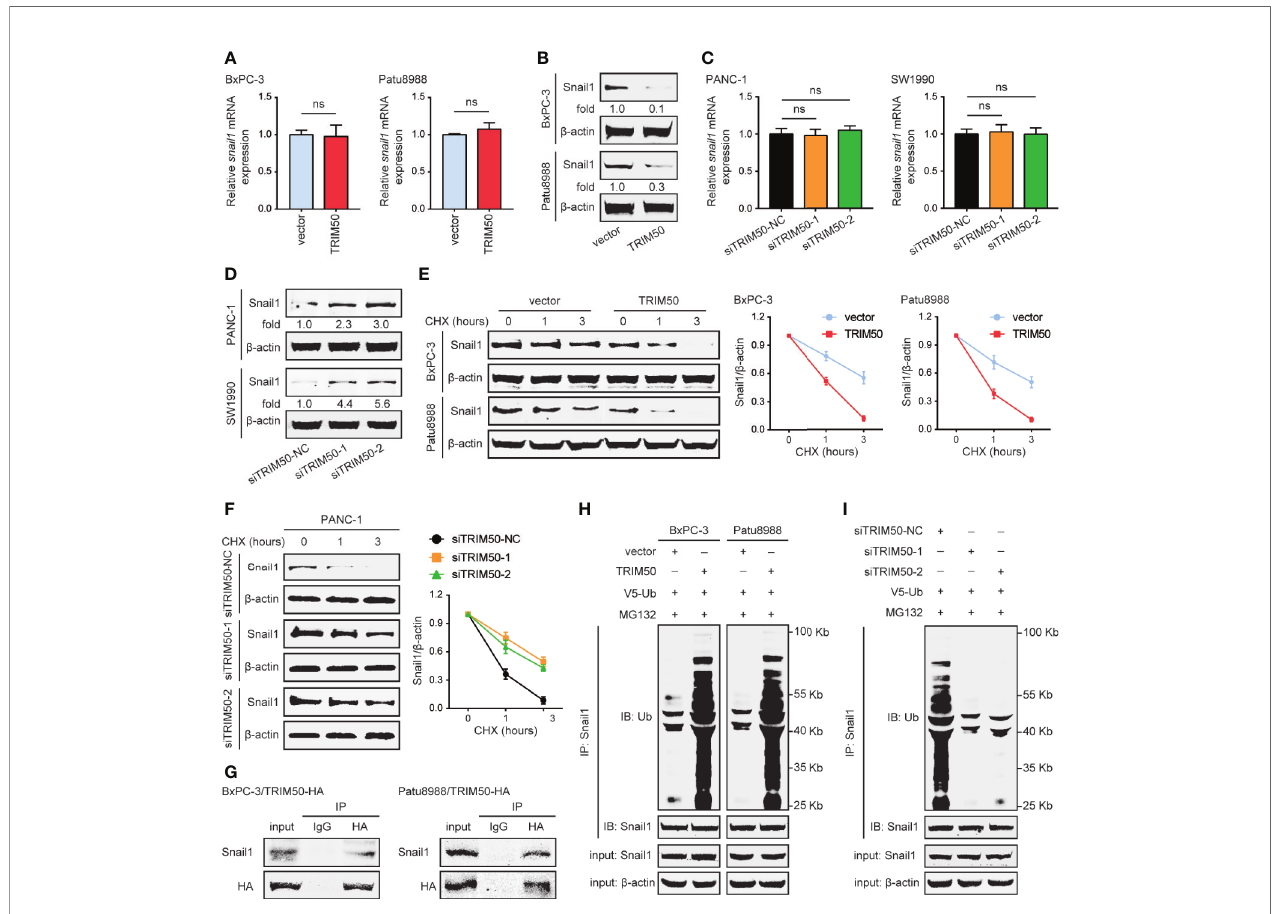
FIGURE 5 | TRIM50 interacts with Snail1 for its ubiquitous degradation. (A, B) The effect of TRIM50 overexpression on Snail1 expression level at mRNA (A) and protein (B) levels. (C, D) The effect of TRIM50 depletion on Snail1 expression level at mRNA (C) and protein (D) levels. (E) TRIM50 overexpression destabilized Snail1 protein expression. Western blotting showing Snail1 in TRIM50-overexpressing and vector control cells as indicated (left panel). Cells were harvested at the indicated times following cycloheximide (CHX) treatment to inhibit new protein synthesis. Quantitation of Snail1 normalized to the loading control and expressed to 0 hour (right panel). (F) TRIM50 depletion stabilized Snail1 protein expression. Western blotting showing Snail1 in TRIM50 depletion and vector control cells as indicated (left panel). Quantitation of Snail1 conducted as TRIM50 overexpression (right panel). (G) BxPC-3 and Patu8988 cells were transfected with HA-tagged TRIM50 plasmids and subjected to CoIP of TRIM50-HA with endogenous Snail1 48 hours later. TRIM50 was immunoprecipitated with an HA antibody, Snail1 bound to TRIM50 was determined using a Snail1 antibody. (H) BxPC-3 and Patu8988 cells with or without TRIM50 overexpression were transfected with V5-ubiquitin (V5-Ub) plasmids, pretreated with 10 m M MG132 for 6 hours and subjected to anti-Snail1 IP followed by anti-ubiquitin (Ub) with western blotting analysis 48 hours later. (I) PANC-1 cells with or without TRIM50 depletion mediated by siRNAs were subjected to experiments as described for (H) . ns, no signi fi